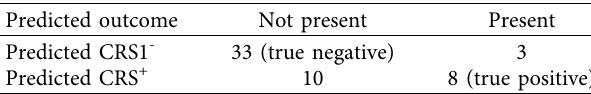
Table 5: Confusion matrix in the model predicting